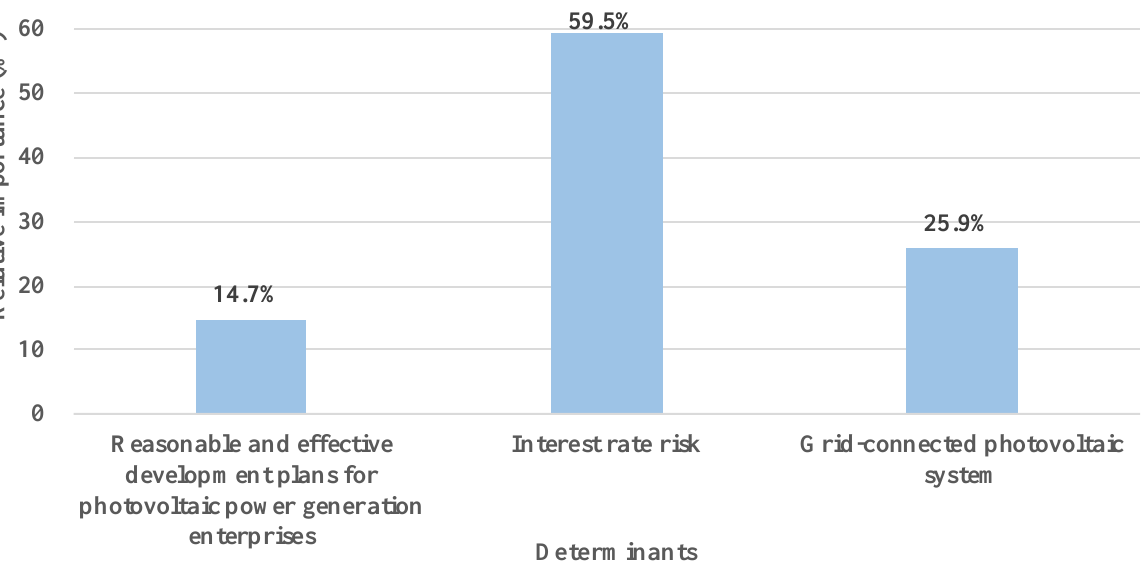
Figure 5. Relative importance of the firm strategy, structure, and rivalry determinants.